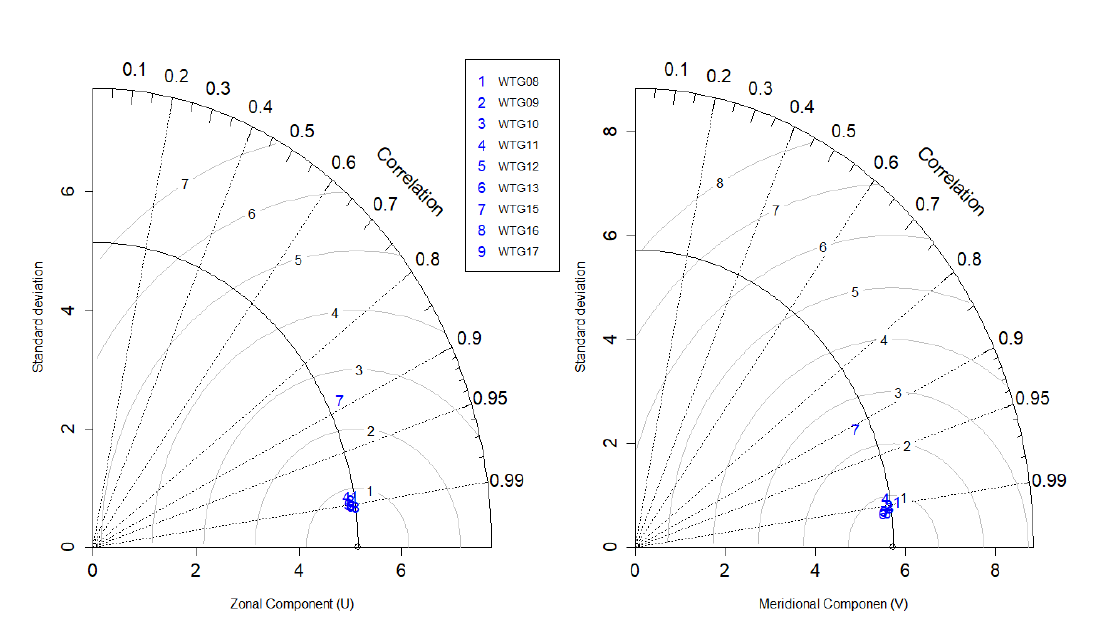
Figure 6. Taylor diagrams taking one of the faultless anemometers as the reference: ( left ) zonal component; ( right ) meridional